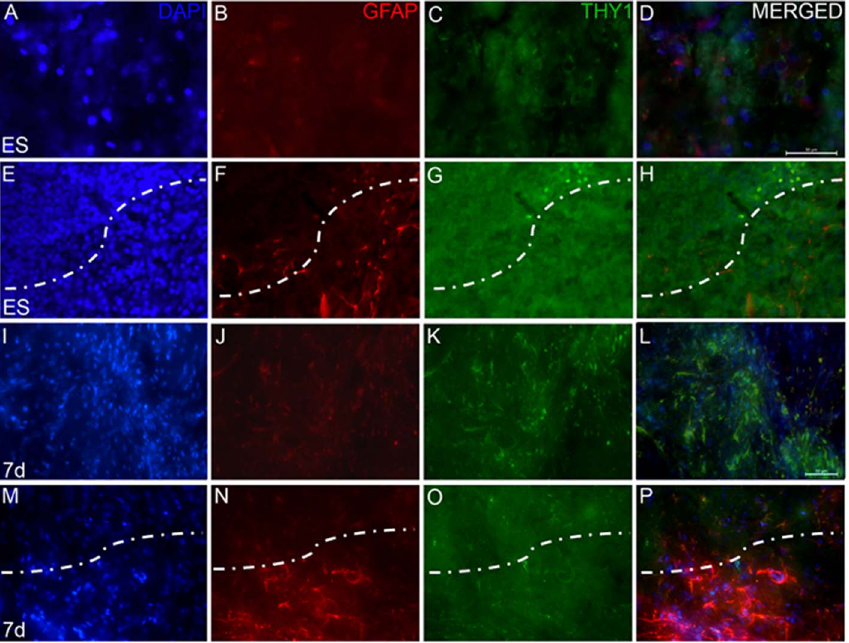
Figure 9. Co-localization of GFAP and murine specific thymocyte antigen 1. Striatal sections of 20 m m thickness of embryonic stem cells, undifferentiated (ES; A–H) and 7 days differentiated cells (7 d; I–P) transplanted group were co-stained for glial fibrillary acidic protein (GFAP; B,F,J,N) and murine specific thymocyte antigen 1 (THY1; C,G,K,O) to examine the origin of these glial cells. Figures A–D and I–L are images from locations within the graft, whereas E–H and M–P are locations along the margin of the graft, showing the host tissue and graft. The dotted lines demarcate the margin. GFAP staining is seen outside the graft margin, whereas THY1 positive cells are seen only inside the graft. Scale bar 50 m m.